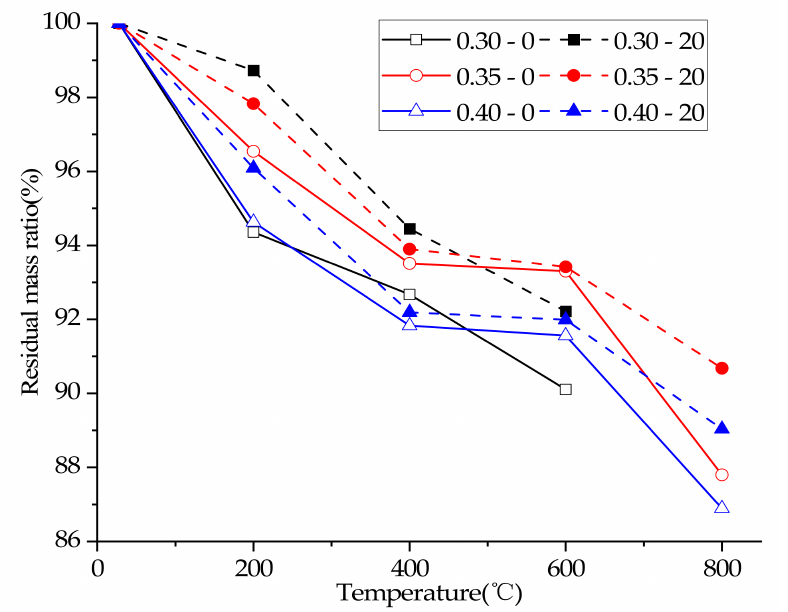
Figure 1. Residual mass ratio of